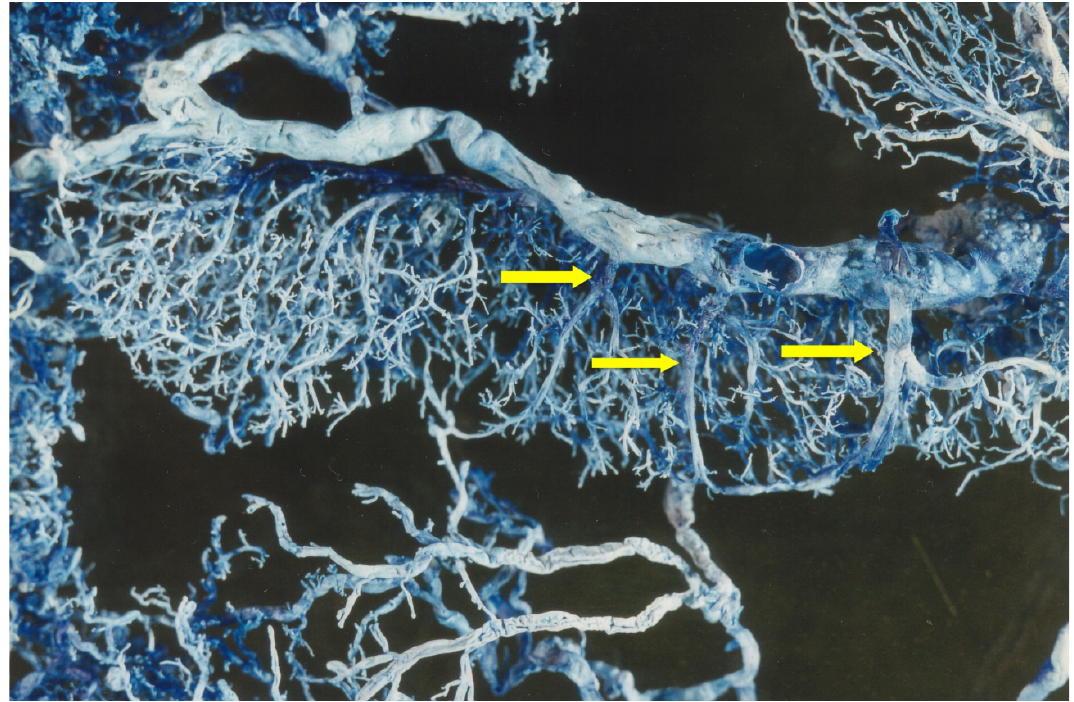
FIGURE 2 - Posterior view of the pancreatic venous vascular mold and affluent branches (arrows) to the splenic vein, in anatomical pieces of human